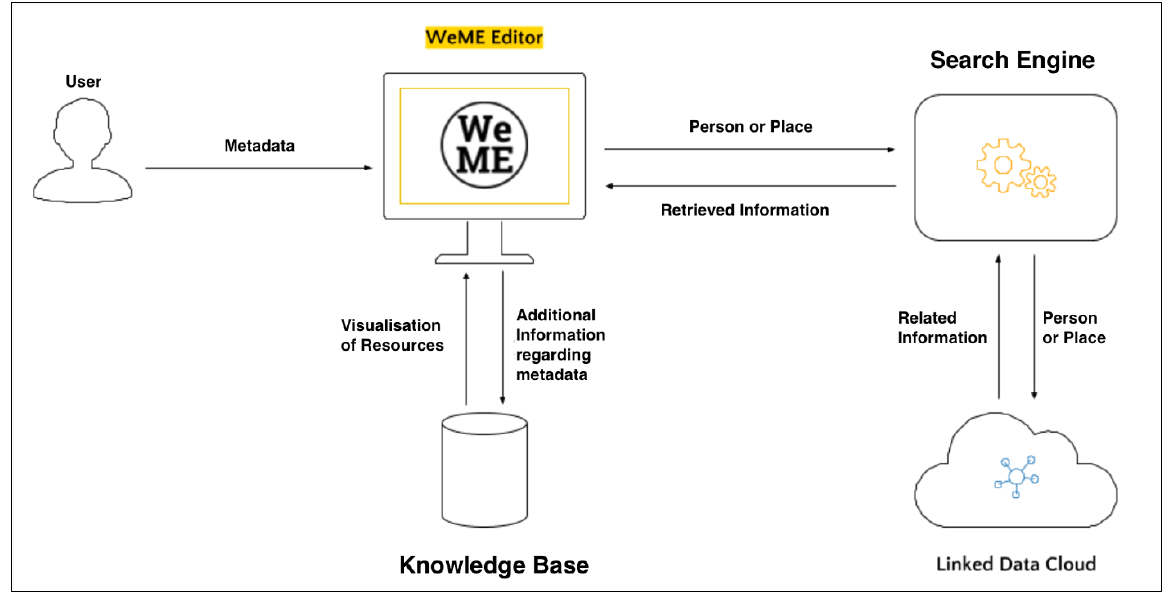
Figure 1. The WeME